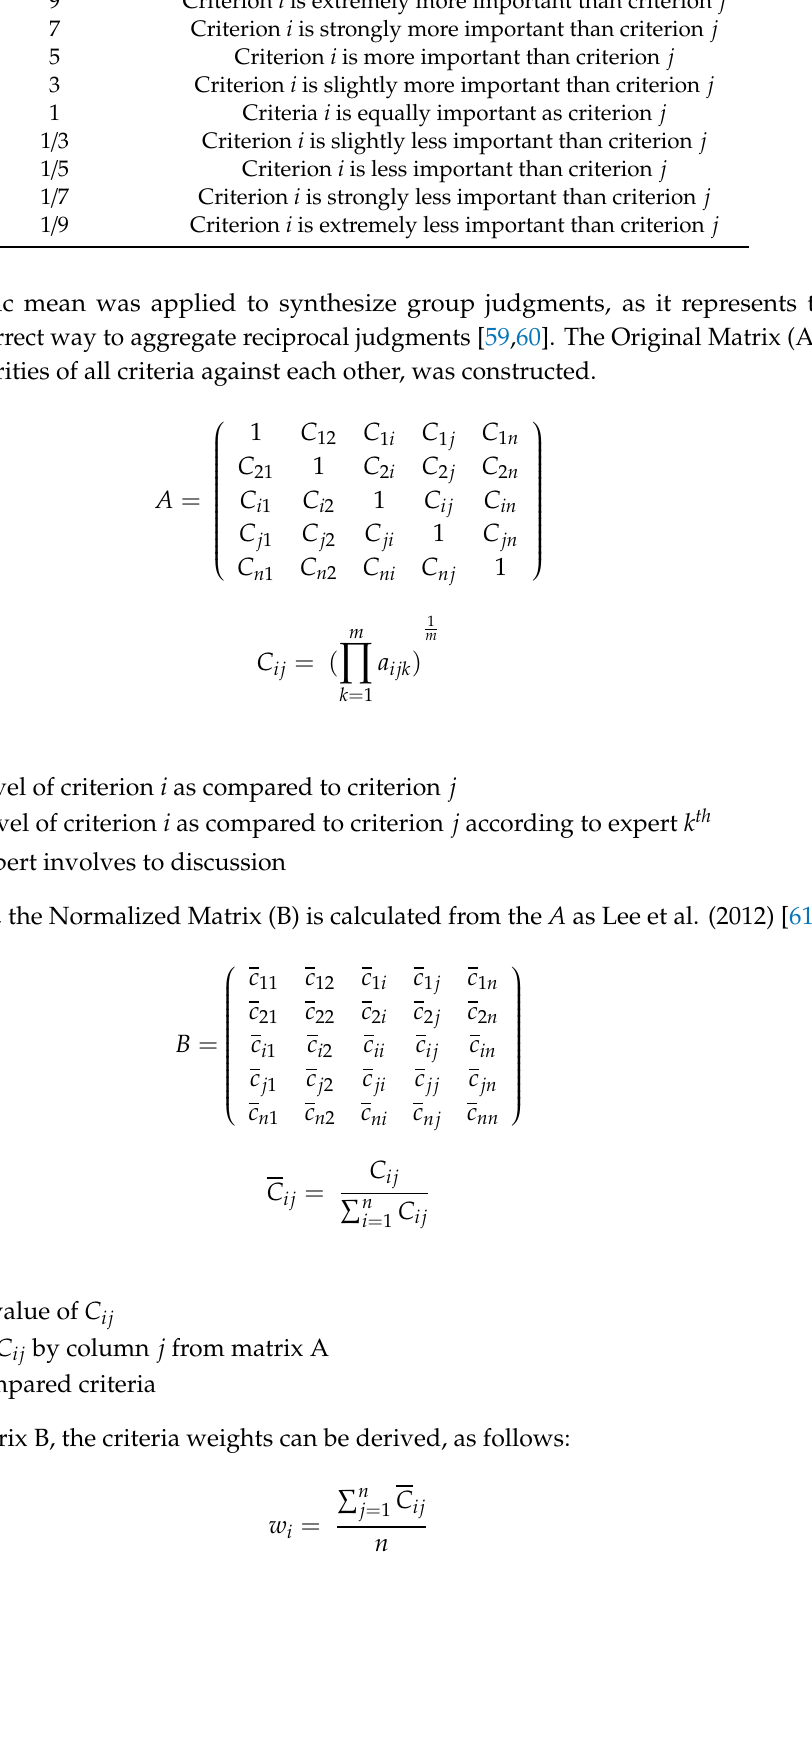
Table 3. Verbal and numeric scale for the pairwise comparison of criterion according to the Analytical Hierarchy Process. Numeric Scale Criterion i is extremely more important than criterion j